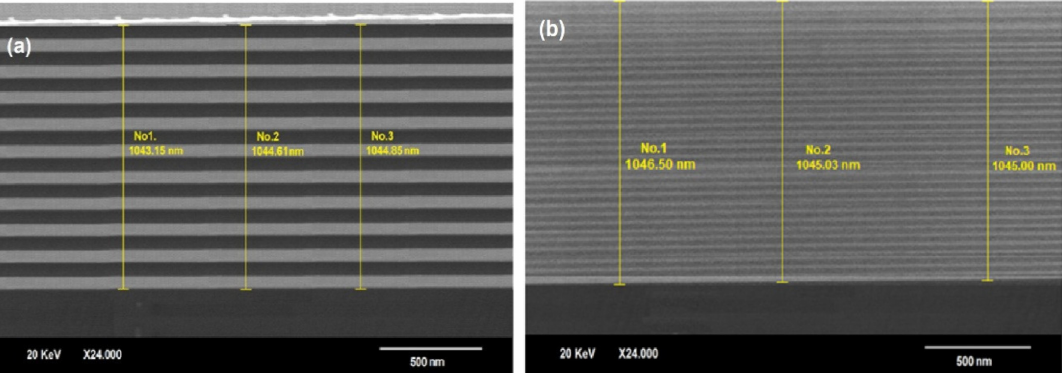
Figure 9. SEM micrographs of the cross section of the [AlN/CoN]n multilayer coatings: ( a ) [AlN/CoN] 10 Λ = 104.3 nm and ( b ) [AlN/CoN] 30 ( Λ = 34.7